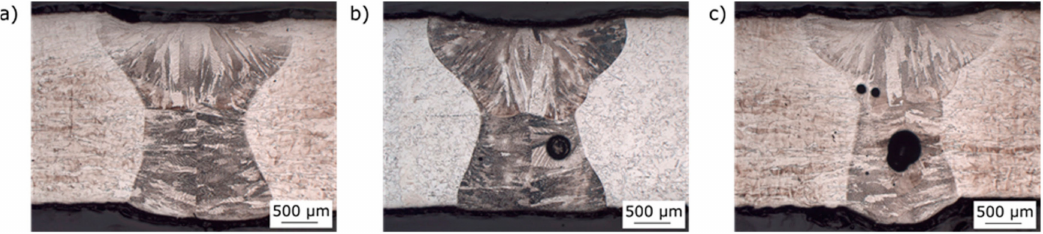
Figure 13. Cross sections of SLM-manufactured tubes of IN625 (overlap area): ( a ) IN625_WOHT_SLME, ( b ) IN625_HT_SLME, and ( c )